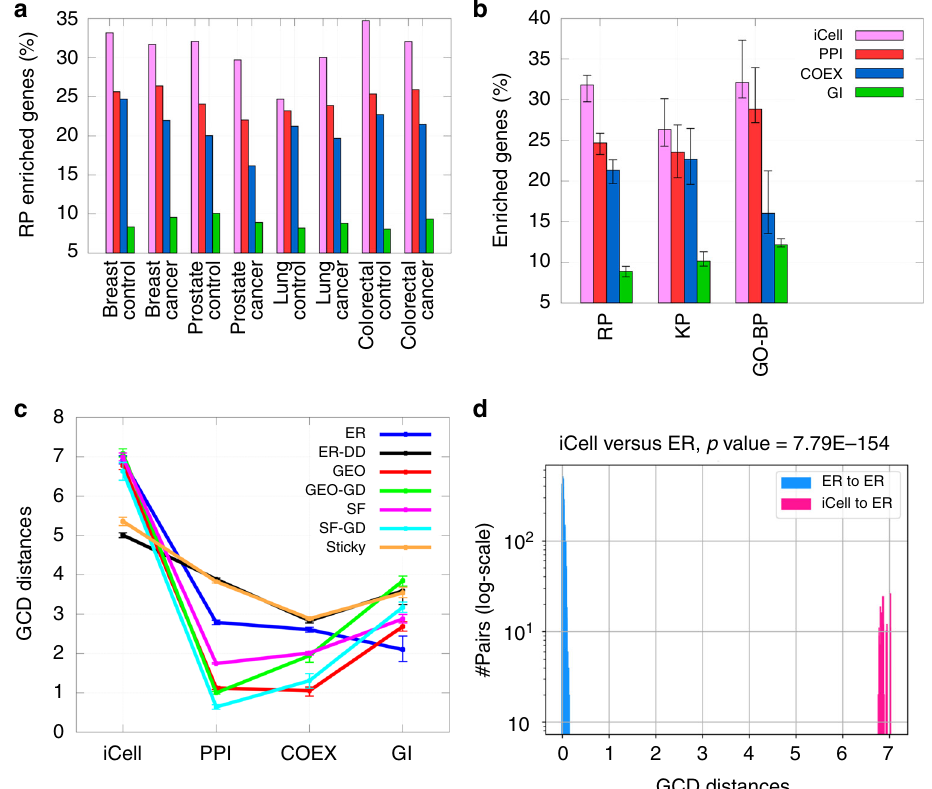
Fig. 2 Functional relevance of iCells. a For each of the four cancers and four control tissues, we created clusters of genes either by integrating all datasets (iCell, in pink), or by considering each dataset in isolation (PPI in red, COEX in blue, and GI in green), as detailed in Methods. For each clustering, the bars show the percentage of the reactome pathway (RP) annotated genes having at least one annotation that is enriched in the clusters. b The same as a , but averaged over all tissues and according to each of reactome pathway (RP), KEGG pathway (KP), and gene ontology biological process (GO-BP) annotations. Error bars show the standard deviations across different tissues. c Each line shows the fi tting of a network model (color coded, Erdös – Rènyi (ER), generalized random (ER-DD), geometric (GEO), geometric with gene duplication (GEO-GD), scale-free (SF), scale-free with gene duplication and divergence (SF-GD), and stickiness-index based model (STICKY)) for the different types of real-world networks ( x -axis), the error-bars show the averages and standard deviations of the pairwise GCD distances between real and 840 randomly generated networks of the size as the real networks. All data, apart from GI networks (which are the most sparse) are structured, in the sense that their GCD distances from ER networks are larger than from other network models. d The distribution of distances between iCell and ER networks (in pink) and the distribution of distances between ER networks (in blue) are signi fi cantly non-overlapping (MWU p value ≤ 5%), indicating that the ER model does not fi t the iCell, i.e., that the structure (topology) of iCell is not